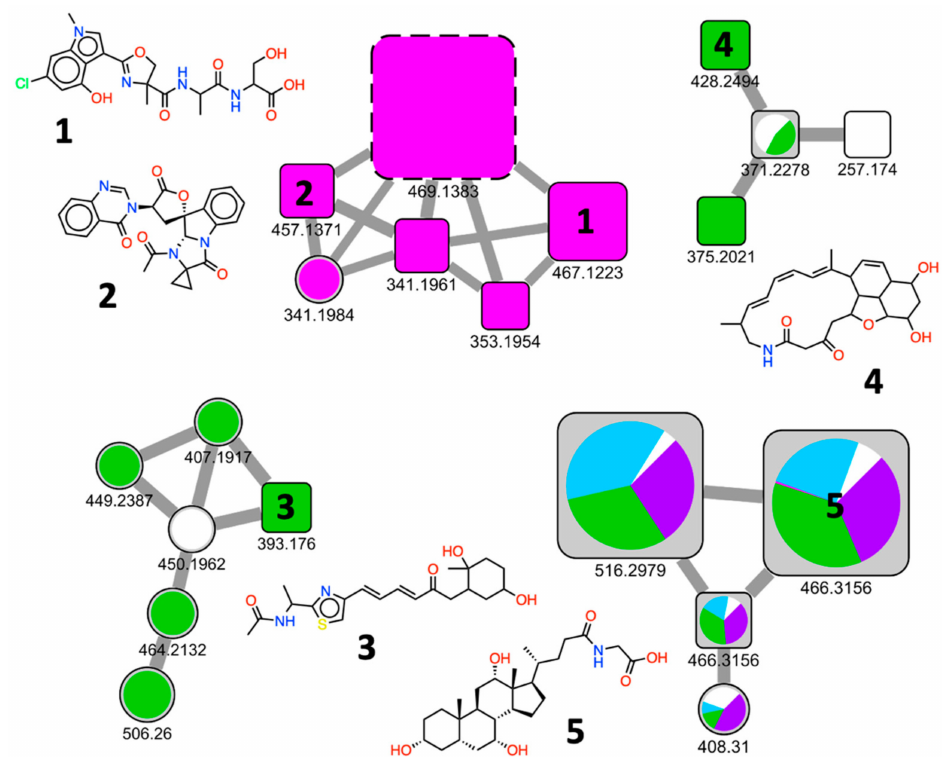
Figure 5. Chemical elicitation induced the production of rare and bioactive bacterial secondary metabolites. Selected clusters of consensus spectra were extracted from the SSMN of the EPfB library. JBIR-35 (1, m / z 467.1223) and tryptoquivaline K (2, m / z 457.1371) were coherently identified from a six-membered cluster elicited by kanamycin. In the same cluster, the major compound m / z 469.1383 (dashed lines) was denoted by a clear chlorine isotope pattern, incompatible with the proposed compound in the database, its identification being ignored from now on. Bacterial compounds leinamycin (LNM) K-3 (3, m / z 393.1760) and verticilactam (4, m / z 428.2494) are also highlighted in two clusters composed mainly by [M + H] + consensus spectra derived from the EDTA elicited conditions. Glycocholic acid (5, m / z 466.3156), a compound found in marine bacteria, was found comprising a cluster of cholic acid derivatives in most of the growth conditions evaluated. Identified nodes are represented in squares; relative peak areas are represented in the pie-chart, colored according to the elicited growth condition: ampicillin (blue), kanamycin (magenta), procaine (purple), sodium butyrate (red), EDTA (green) and control conditions